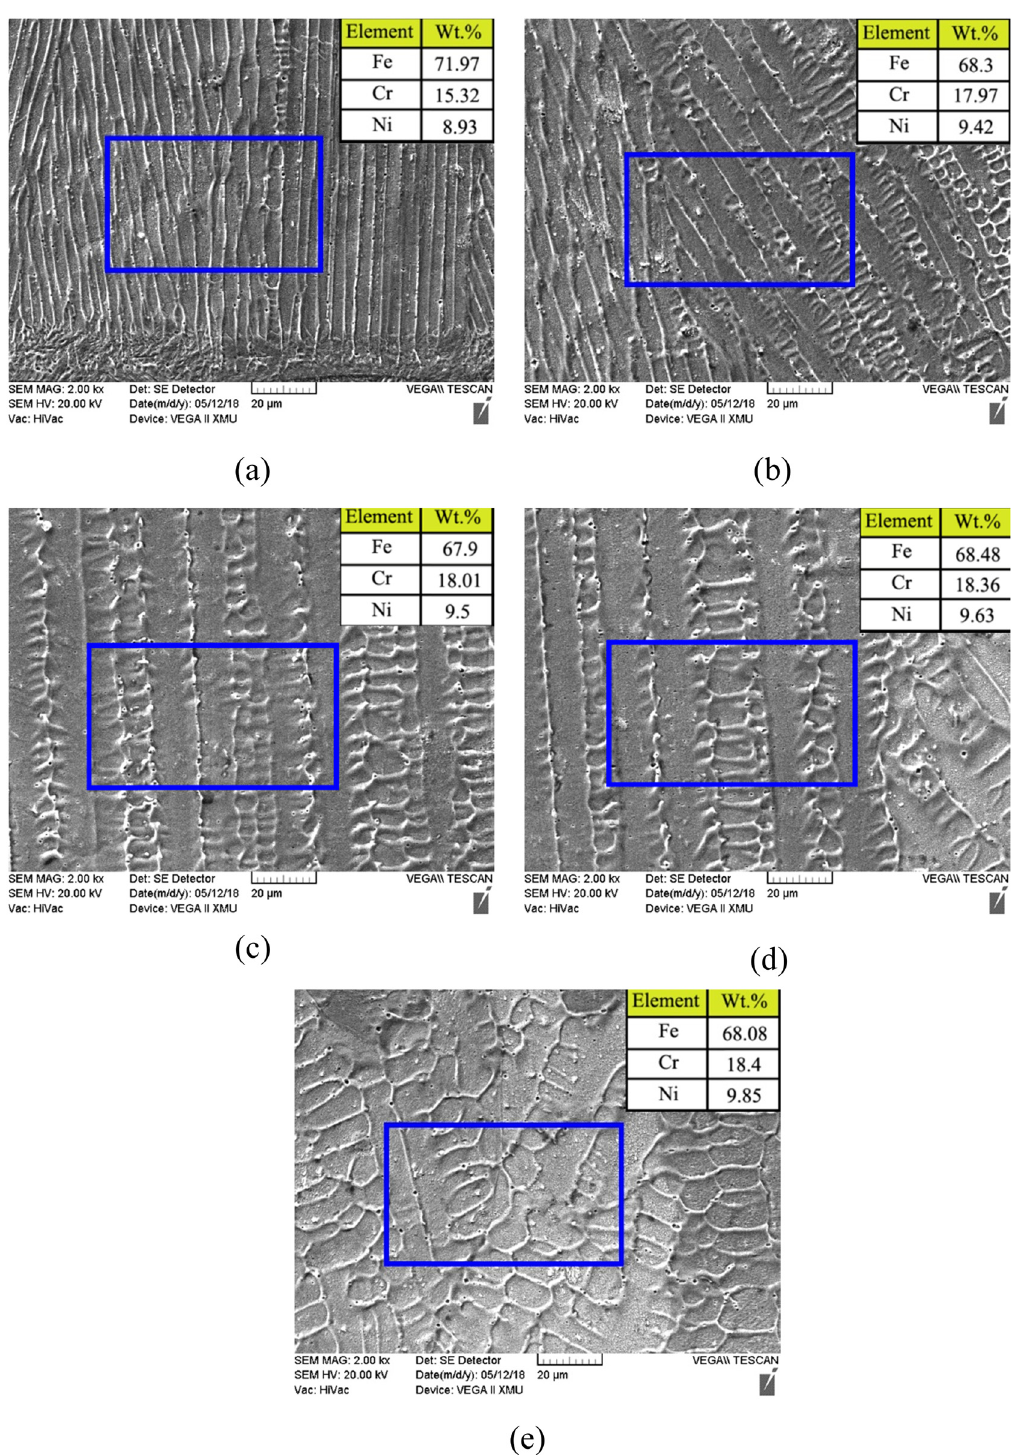
Figure 7: Energy spectrum analysis results for di ff erent sampling areas in the cladding layer obtained at 10 mm · s − 1 scan speed: ( a ) the area of A; ( b ) the area of B; ( c ) the area of C; ( d ) the area of D; and ( e ) the area of